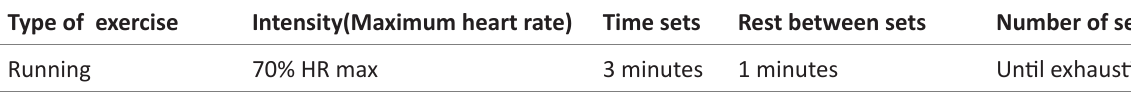
Table 2. Anaerobic exercise program for one session Type of exercise